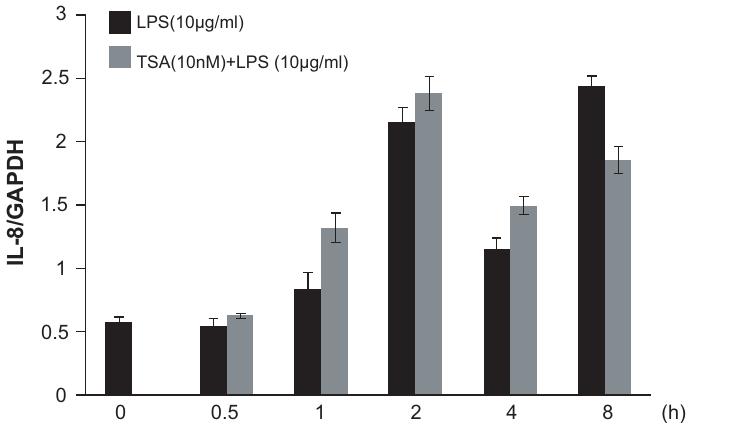
Figure 5. Time course analysis of trichostatin A (TSA) on lipopolysaccharide (LPS)-stimulated interleukin-8 (IL-8) gene activation from A549 cells in vitro . TSA at 10nM treated 1 h before LPS stimulation (10μg/ml) tended to show a stimulatory effect on LPS-induced IL-8 gene activation. After 0 ~ 8 h, the levels of IL-8 mRNA were analyzed by quantitative reverse transcription polymerase chain reaction (qRT- PCR). The IL-8 mRNA levels were normalized to glyceraldehyde-3-phosphate dehydrogenase (GAPDH) levels, n=4.